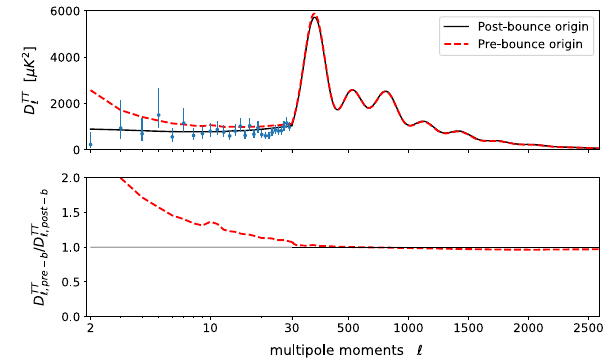
Fig. 11 Temperature angular power spectra D TT (cid:16) for a pre-bounce and forapost-bounceoriginofstructures,withbackgroundIC {− 0 . 41 , − 1 } , and quadratic potential. Top: D TT (cid:16), inblack, D TT (cid:16), in black, D TT (cid:16), in dashed red, L , post-b pre-b post-b pre-b Planck data in blue. Bottom: Ratio of the spectra in dashed red